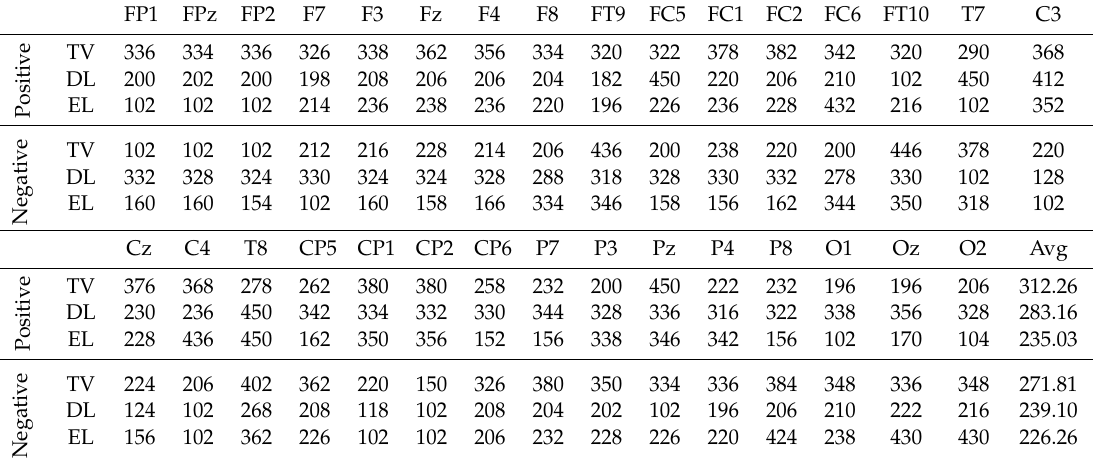
Table 1. Latencies of the positive and negative component during each device control.